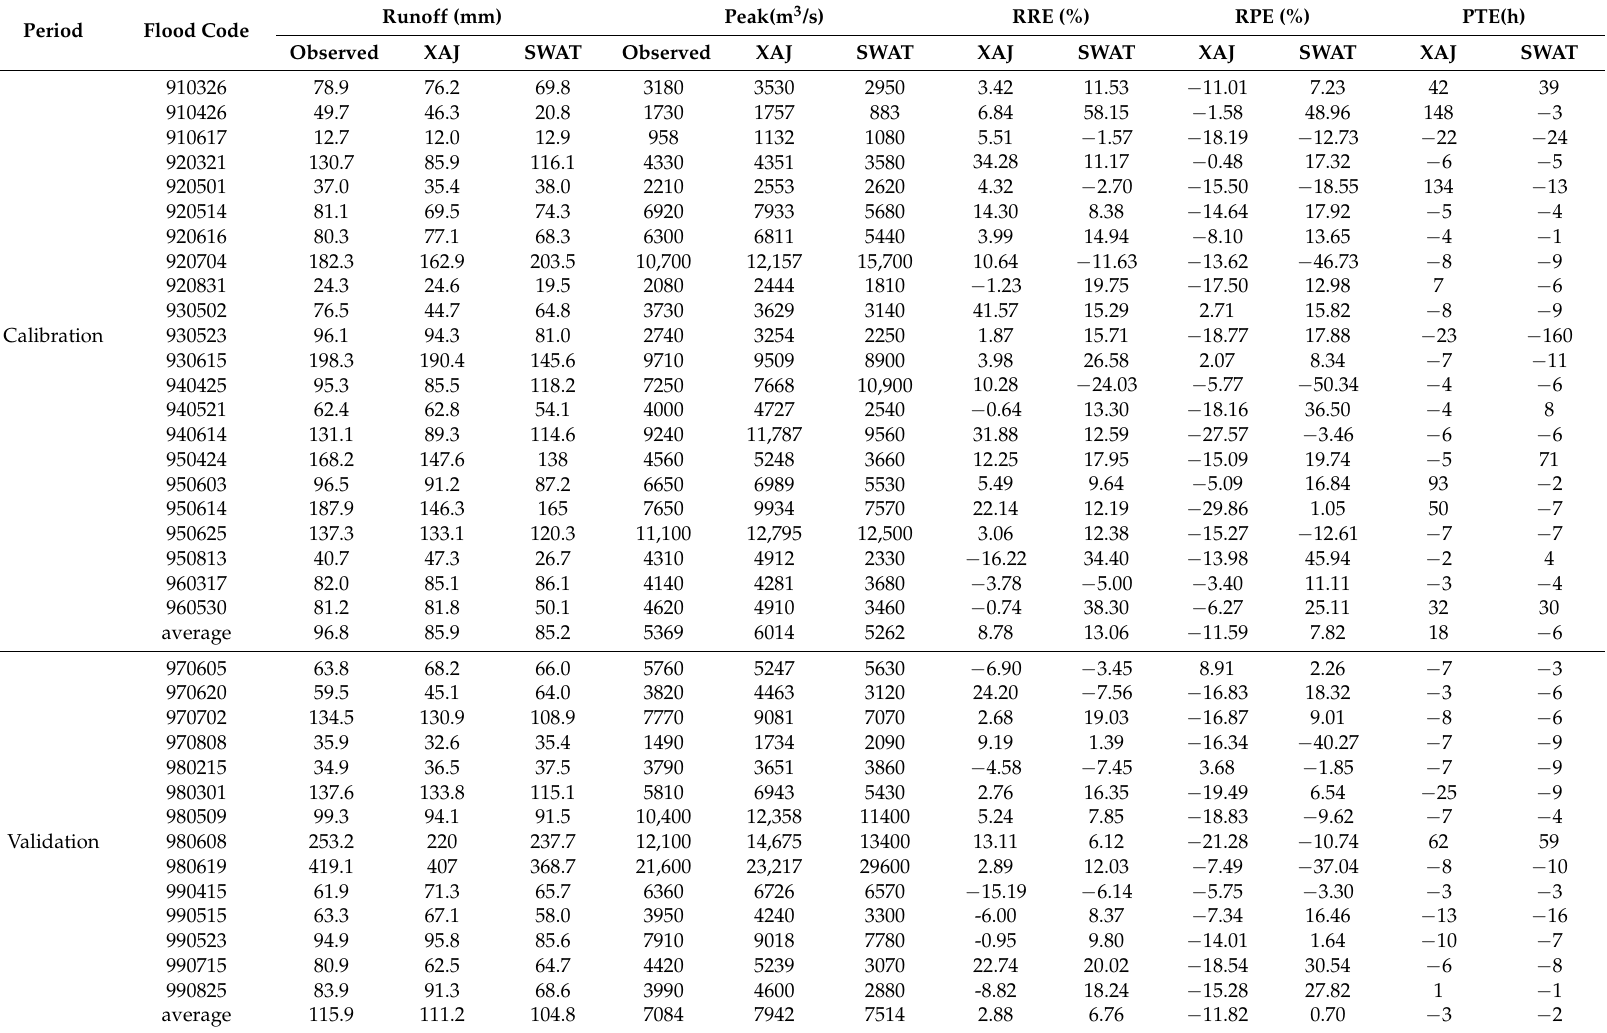
Table 5. Parameter sensitivities for SWAT model in daily and flood